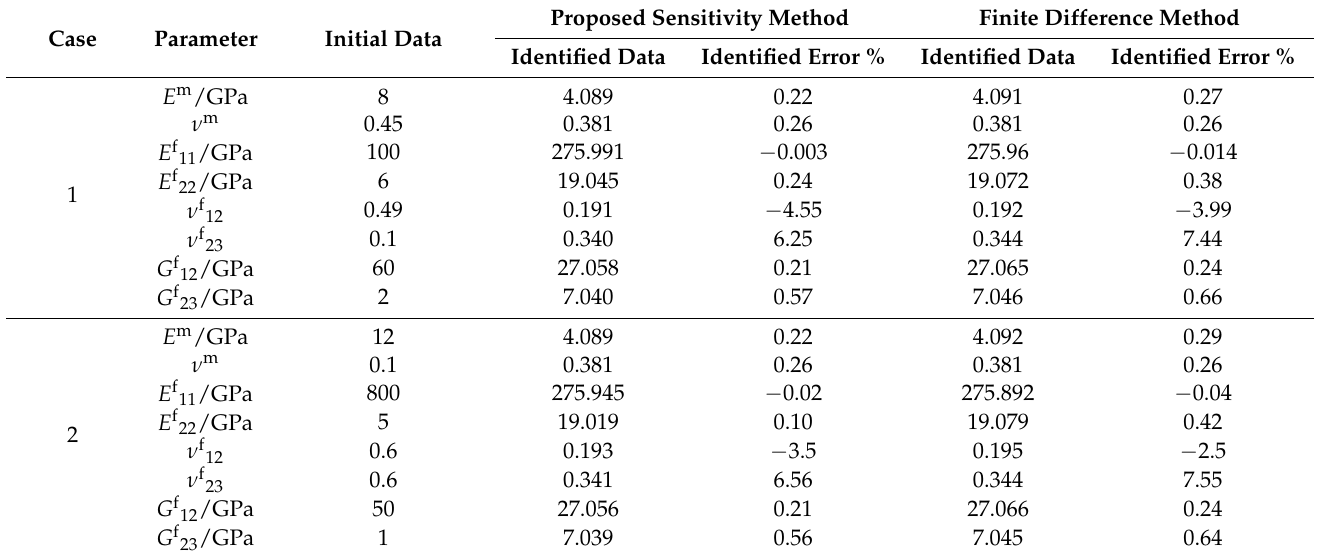
Table 3. Identification result for two sensitivity methods (six points).